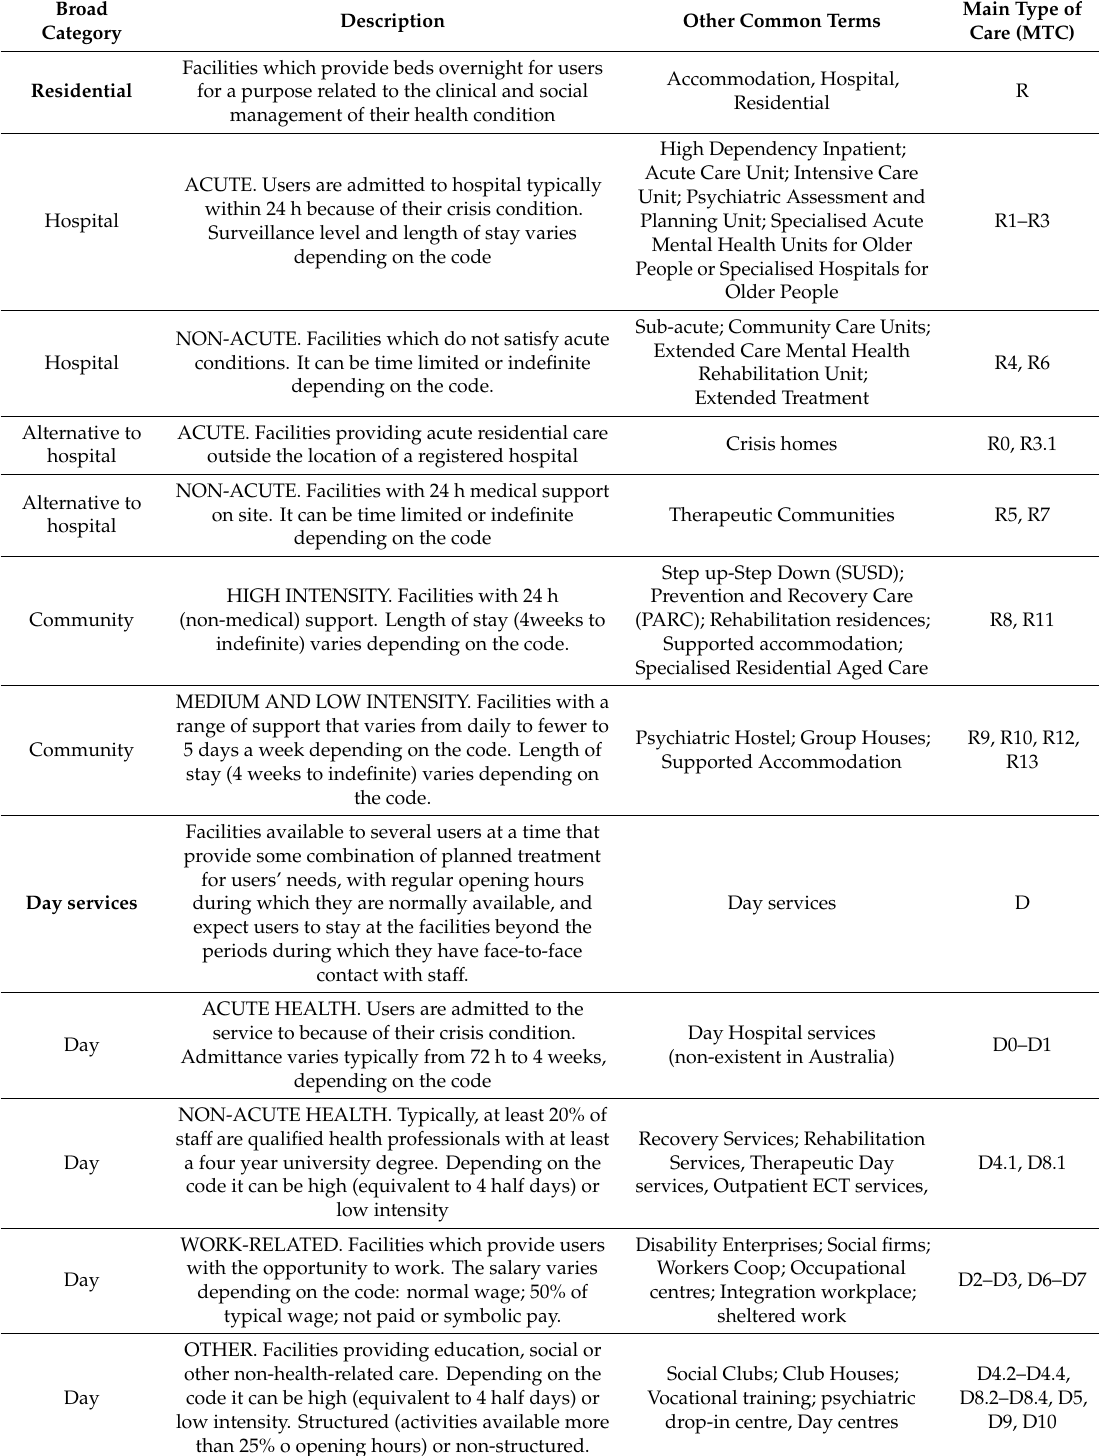
Table A1. Glossary of DESDE-LTC Main types of care (MTC), descriptions and common